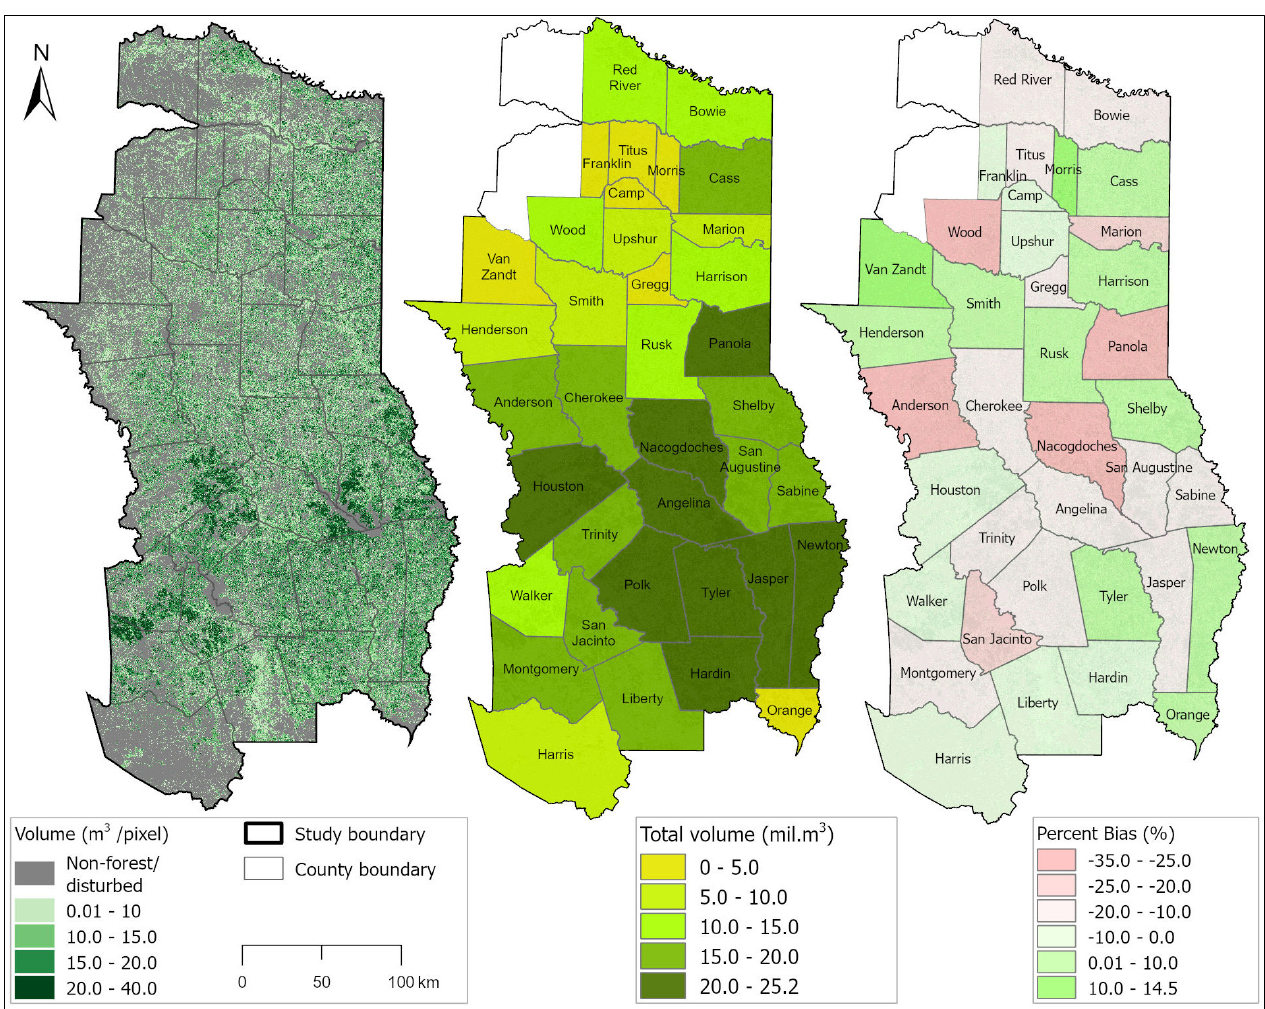
Figure 7. Regional stem volume mapping and comparison with FIA estimates: (left) stem volume product in cubic meters generated in this study; (middle) FIA county-level total stem volume estimates in million cubic meters. Counties to the level of Red River and Franklin counties did not have volume estimates; thus, they are not shown in the FIA map. (Right) percent di ff erences between study and IA estimates. The color scheme indicates trends in underestimation (redder hues) and overestimation (greener hues) of FIA estimates.